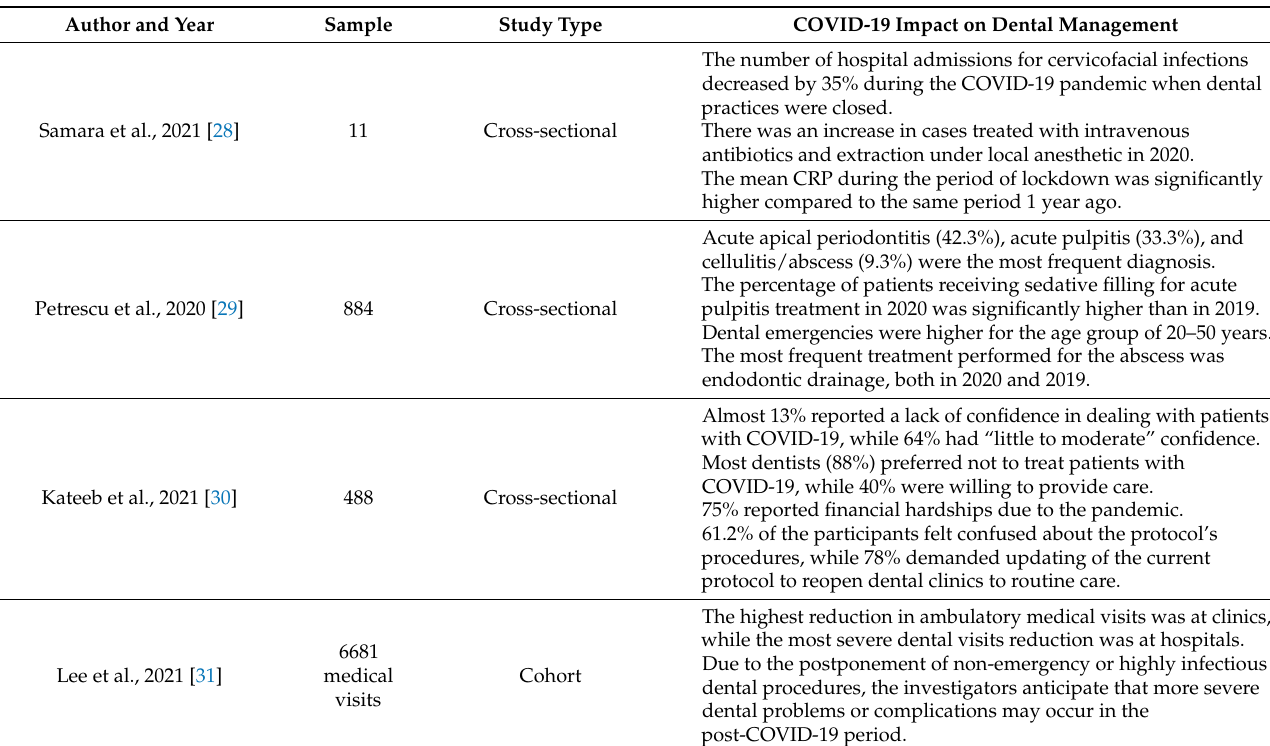
Table 2. The impact of COVID-19 in dental